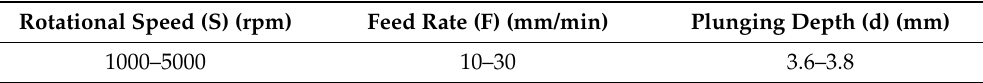
Table 2. Welding conditions for the thermal and forces analyses.